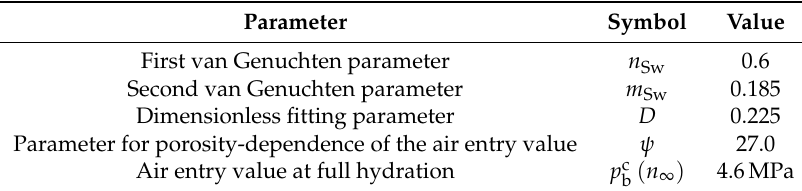
Table 4. Parameters for the desorption isotherm